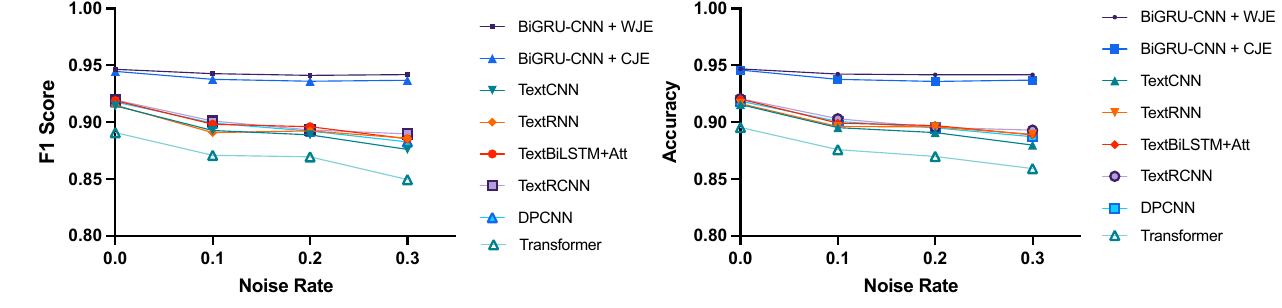
Figure 5. Performance changes in the models with different homophonic noise rates.